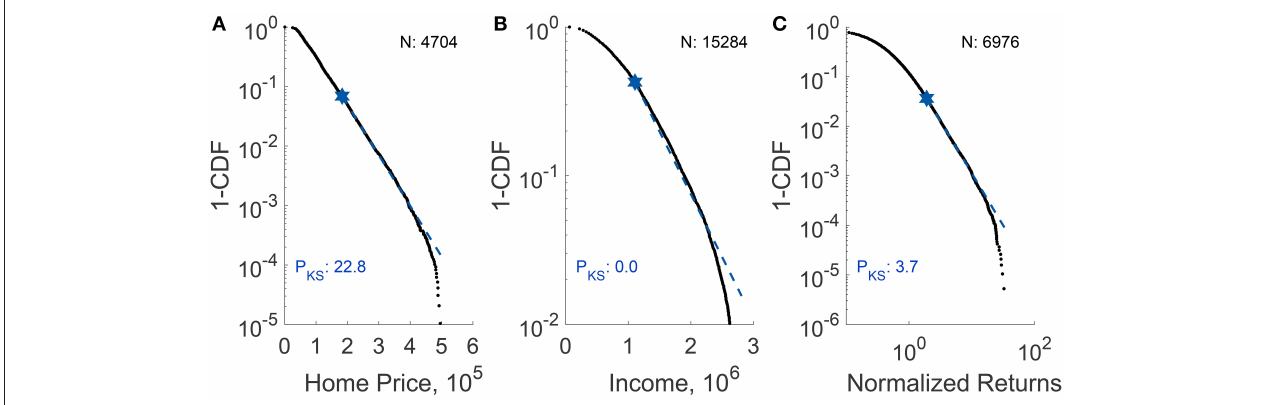
FIGURE 1 | p -testing on (A) 2012–2014 Taiwan home price per square foot, (B) 2012 Taiwan lower-tail income (fitted to EXP), and (C) 2009–2016 Straits Times Index normalized return (fitted to PL). For each plot, N represents the number of data points (larger than x min ) fitted. the black dots represent empirical data while the blue dashed line represents the fit. All fits are visually good, yet only the p -value ( P KS in percentage) for Taiwan home price is